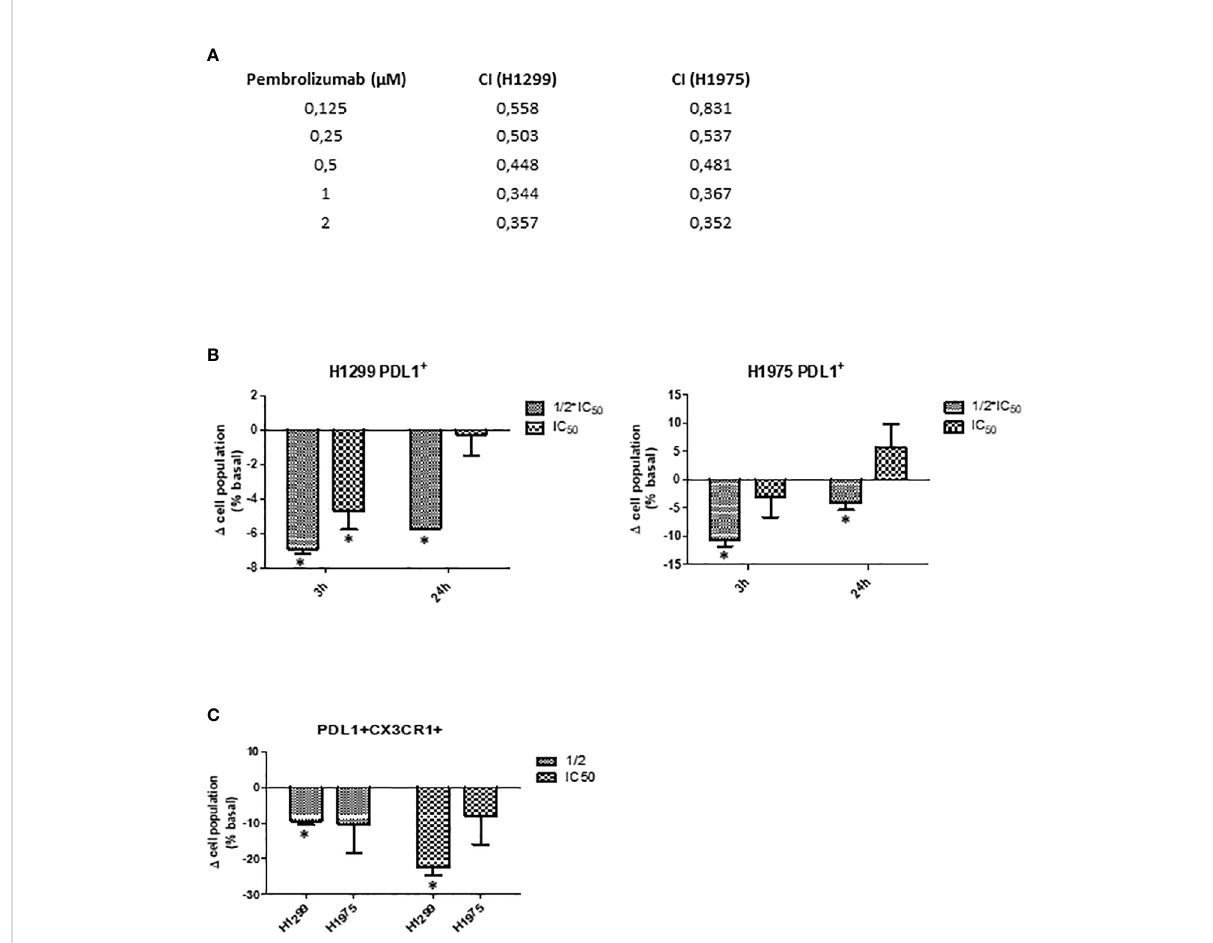
FIGURE 9 SFRE synergised with pembrolizumab in the inhibition of NSCLC cell proliferation. H1299 and H1975 NSCLC cells were treated concomitantly with SFRE at a fi xed dose of 1/2xIC 50 and with pembrolizumab at the indicated doses. (A) The combinatory index (CI) according to Chou – Talay method indicated a positive synergism between SFRE and pembrolizumab in the inhibition of NSCLC proliferation. (B) FACs analysis of the expression of PD-L1 after 3h and 24h SFRE treatment of NSCLC cells at two different doses (1/2xIC 50 , and 1xIC 50 . (C) FACS analysis of the double expression of PD-L1 and CXCR1 after 3h and 24h SFRE treatment of NSCLC cells at two different doses (1/2 IC50, and 1xIC50. Data are expressed as fold induction respect to the expression levels of non-treated cells. Results are expressed as the mean ± SEM of three independent experiments, each performed in triplicates. Asterisks * indicates p-values <